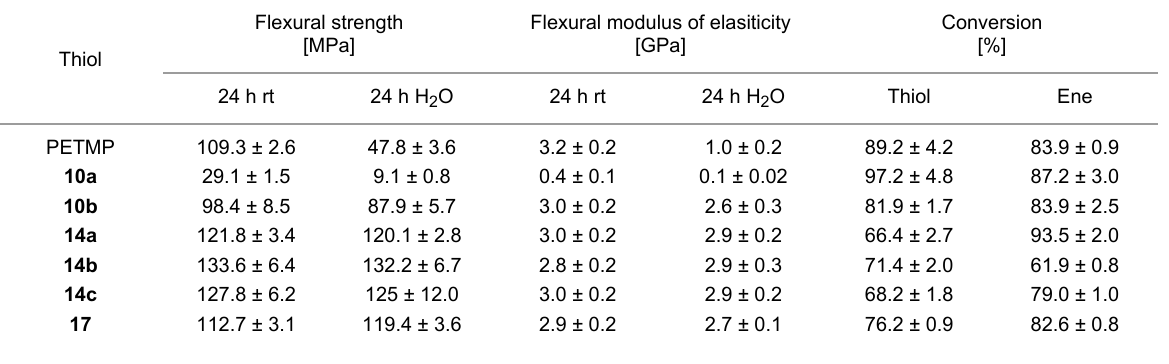
Table 1: Flexural strength and flexural modulus of elasticity before and after storage in H 2 O as well as the conversion. All samples contained a stoi- chiometric amount of TATATO and the below-mentioned thiol, 0.5 wt % initiator (K69) and 0.04 wt % Q1301. Flexural strength Flexural modulus of elasiticity [MPa] [GPa] Thiol